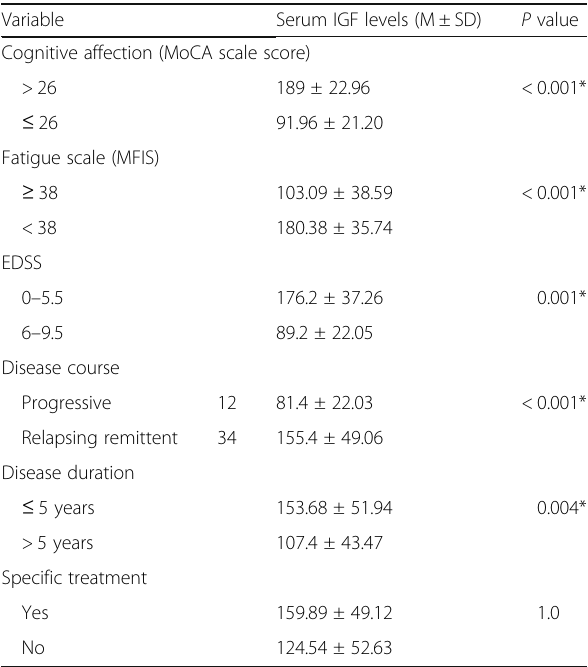
Table 3 Relationship between serum IGF-1 levels and clinical scales and clinical parameters as well as treatment among multiple sclerosis patients